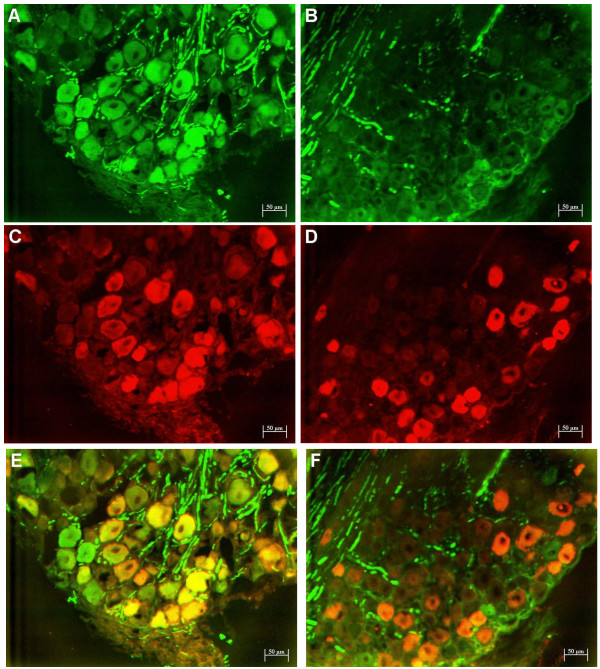
Parvalbumin and pNF-H fluorescent double immunolabelling of rat DRG tissue from control and oxaliplatin-treated animals. Representative DRG sections displaying fluorescent immunolabelling of pNF-H (FITC; green) (A, B) and parvalbumin (Cy3; red) alone (C, D) and overlaid to determine the extent of co-expression (yellow) (E, F) in L5 DRG of animals treated with the control vehicle (A, C, E) or oxaliplatin (B, D, F). Oxaliplatin reduced pNF-H cell body staining and its co-localisation with parvalbumin. The cell bodies of immunoreactive neurons appeared smaller after oxaliplatin. The number of nerve fibres staining for pNF-H and cell bodies staining for parvalbumin appeared unchanged after oxaliplatin. Magnification = 100×.